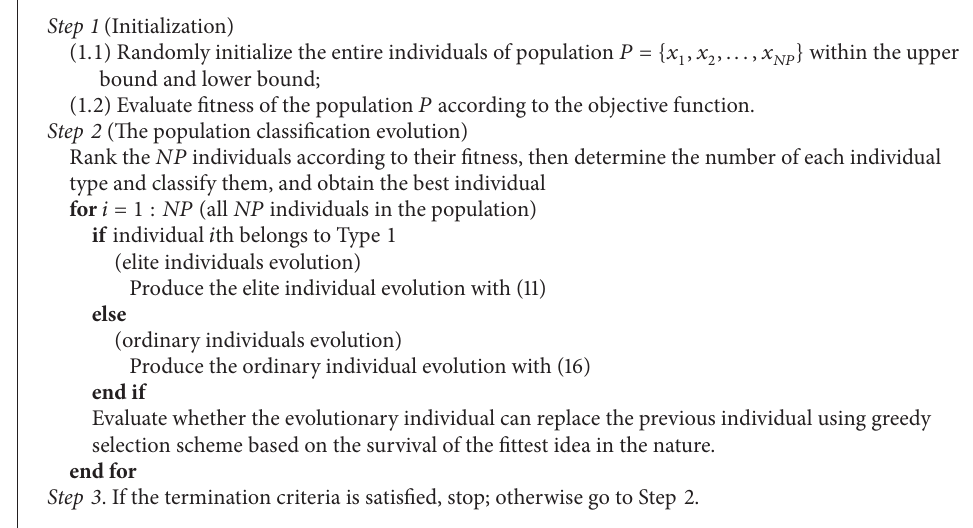
Algorithm 1: Pseudocode of the proposed